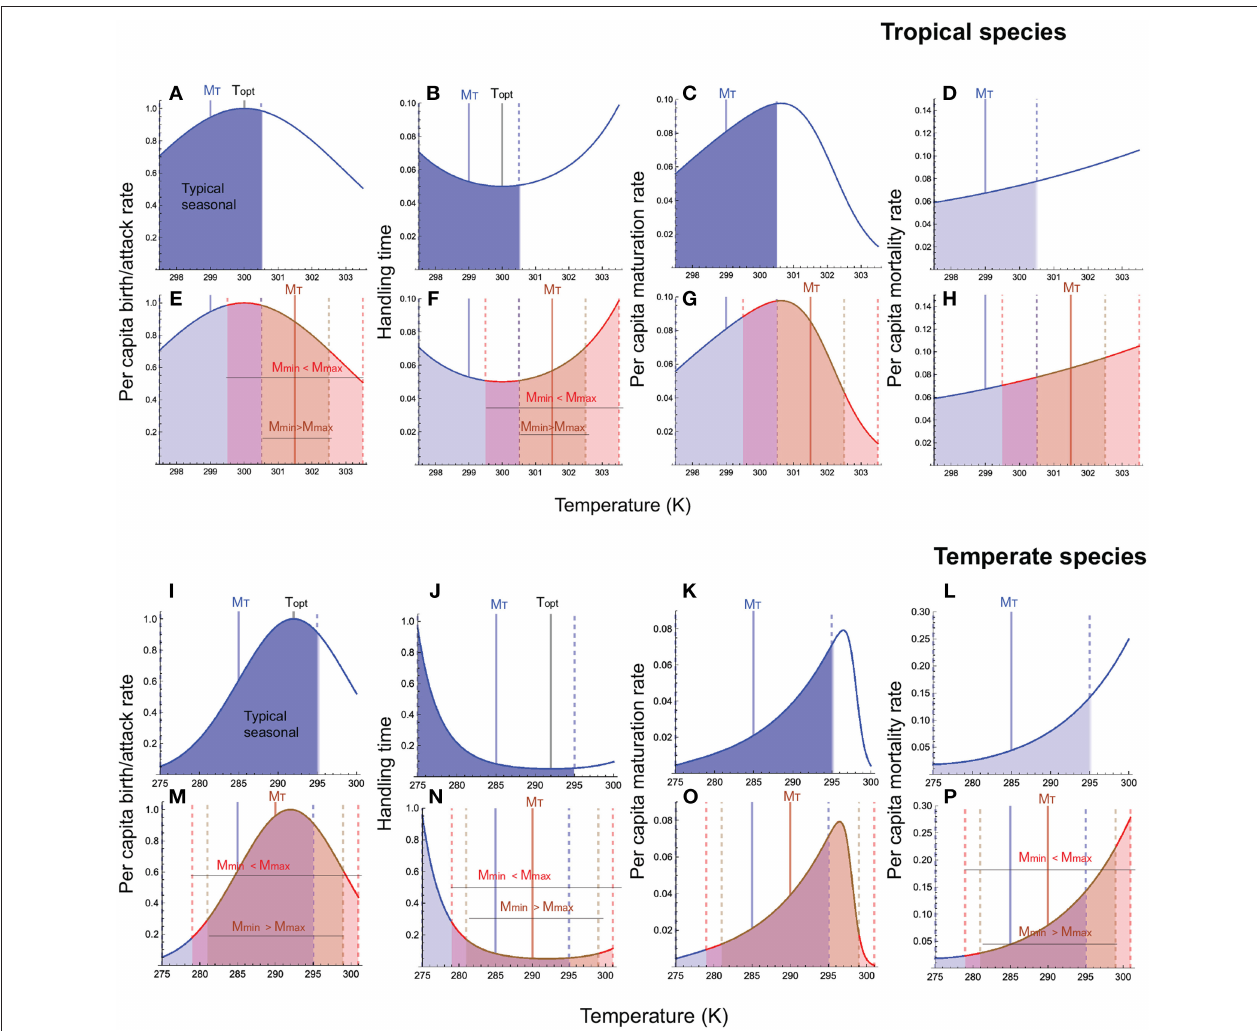
FIGURE 1 | Temperature responses of resource and consumer traits under typical seasonal variation and warming. (A–H) are for tropical ectotherms, and (I–P) , for temperate ectotherms. For each latitude, panels in the top row depict temperature responses under typical seasonal variation, and those in the bottom row, temperature responses under the two warming scenarios: minimum temperature increases faster than the maximum (Min T > Max T ) and minimum temperature increases slower than the maximum (Min T < Max T ). On panels in the bottom row for each species [ (A–D) for tropical and (I–L) for temperate], the blue portion of the response curve depicts the response under seasonal variation, the brown portion of the curve when Min T > Max T , and the red portion of the curve, Min T < Max T . In each panel, the solid blue vertical line depicts the mean habitat temperature and the solid black line, the physiologically optimal temperature; the dashed vertical blue lines depict the temperature range experienced by species under typical seasonal variation, the dashed red lines depict the range when Min T < Max T , and the dashed brown lines, when Min T > Max T . For ease of comparison, increase in minimum and maximum temperature for the two scenarios are chosen such that the mean temperature ( M T ) is the same. Note that the temperature range on the x-axis is smaller in the for tropical species (297.5–303.5 K) than for the temperate = 300, s X = 3.0(X=b, a, h, q), T R = 297(Y=R, C), T L = 296, T H = 302 (Z=J, species (275–301 K). Parameter values for the tropical species are: T opt X Z Y Z L), M T = 299, A T = 1.5 ◦ , m = 3, a = 2 when the minimum temperature increases faster than the maximum and m = 2, a = 3 when the minimum increases more = 292(Y=R, C), T L / 2 = 275, T H / 2 = 298(Z=J, = 292, s X = 6.0(X=b, a, h, q), T R slowly than the maximum. Parameter values for the temperate species are: T opt X Y Z Z L), M T = 285, A T = 10 ◦ , m = 6, a = 4 when the minimum temperature increases faster than the maximum and m = 4, a = 6 when the minimum increases more = a T = 1.0, h T = 0.05, q T = 0.2, f = 1.0, d Y = 0.1, d Z = 0.1, m Z = 0.05, A d = slowly than the maximum. Other parameters are: b T opt opt opt opt TR TR TR Y = 10,000, A L = − 25,000, A L / 2 = − 50,000, A H / 2 = 100,000. = 10,000, A m 10,000, A d Z Y Z Z Z